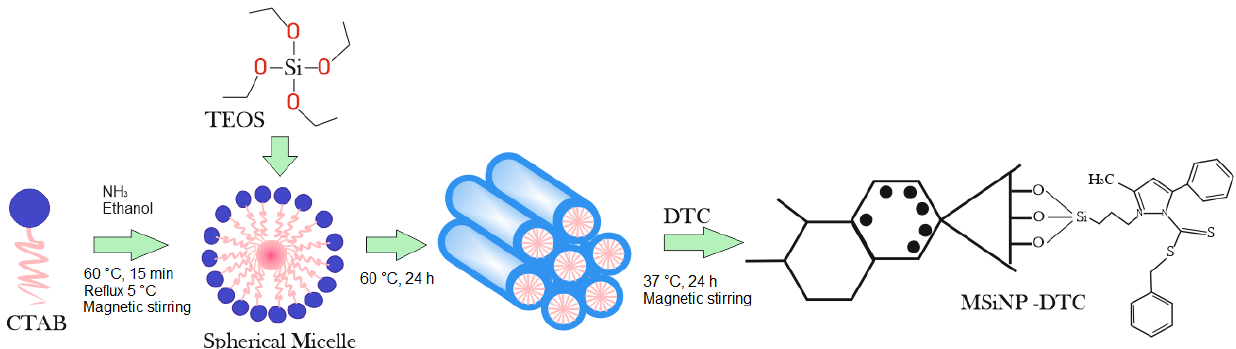
Figure 1. Schematic representation of the synthesis process of 3-methyl-5-phenyl-pyrazoline-1-( S - benzyldithiocarbazate) (DTC).